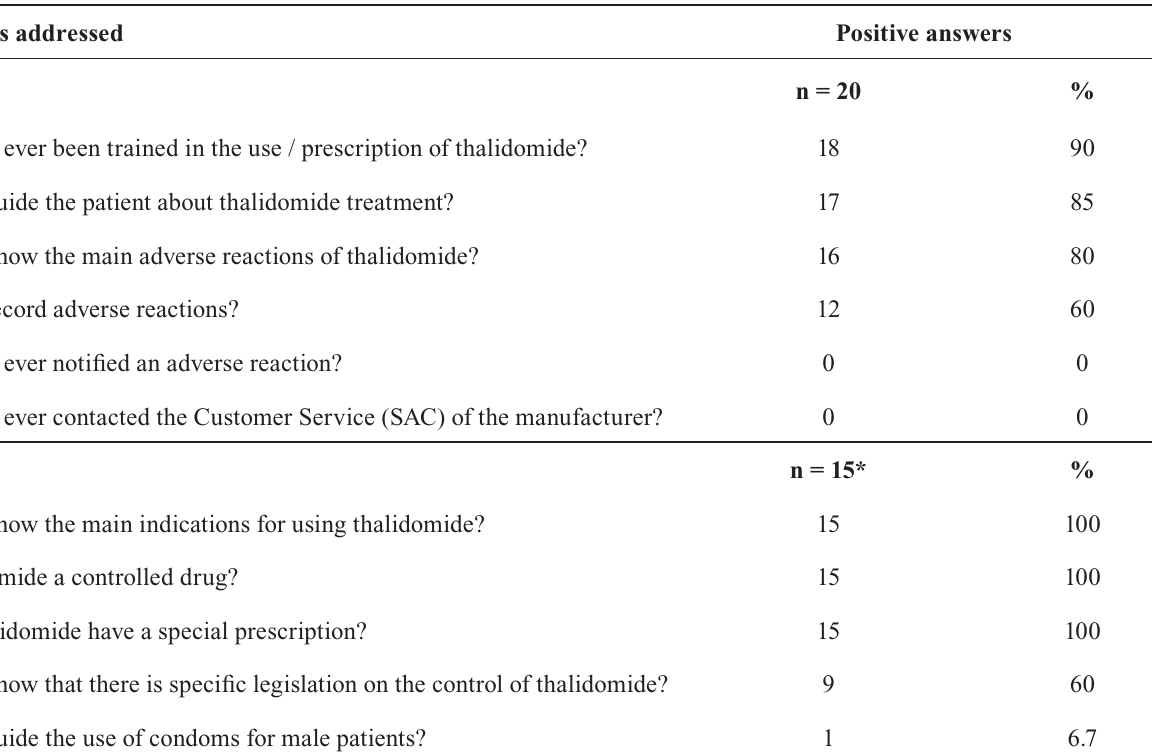
TABLE I - Interviews with health professionals from referral hospital